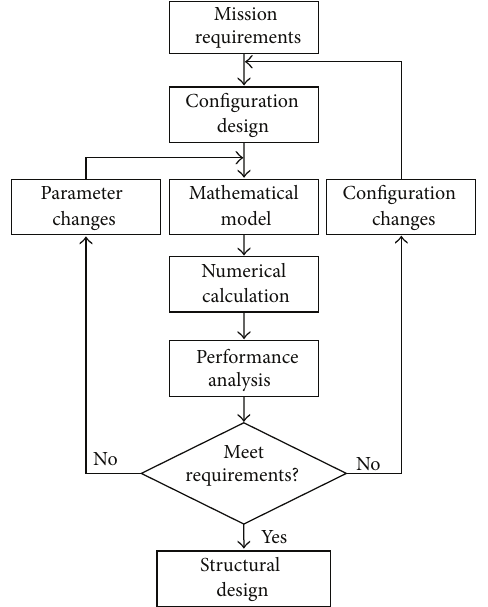
Figure 1: Design process based on mission requirements.